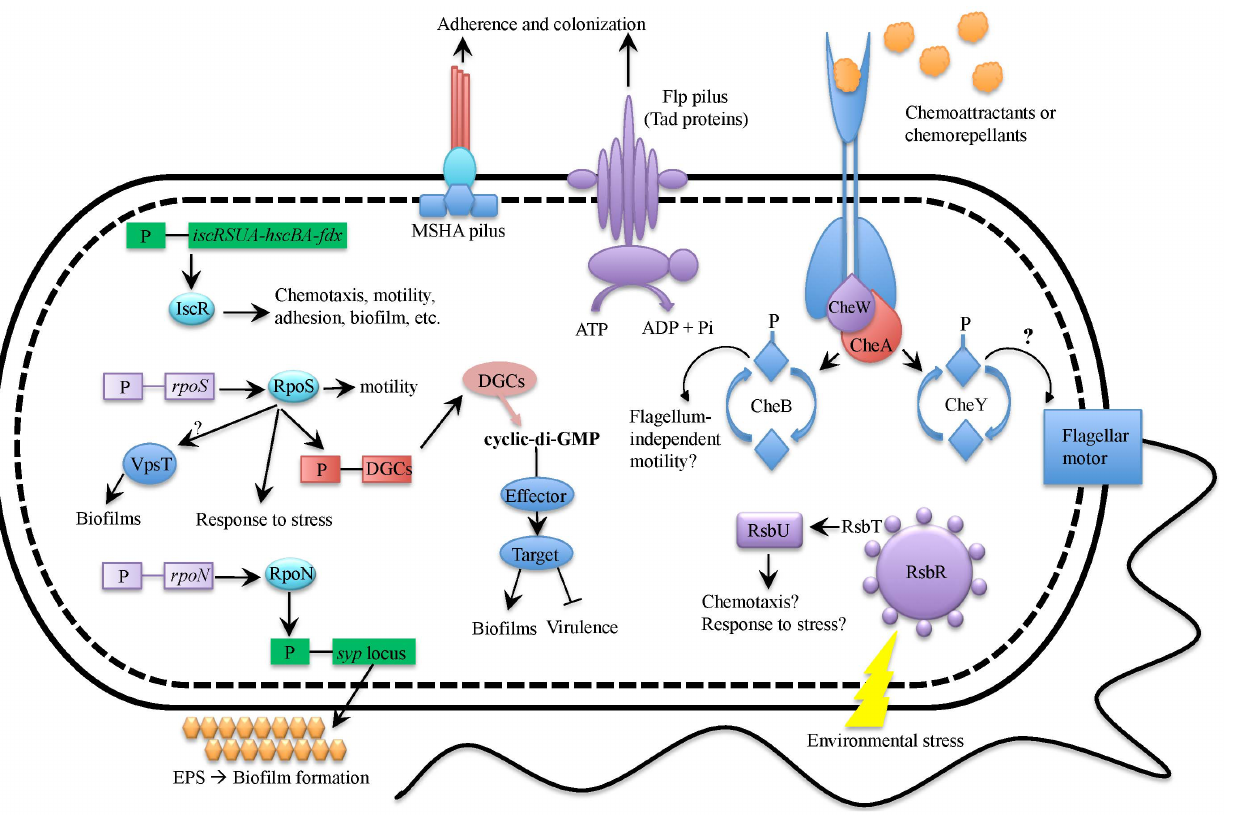
Fig. 7. Diagrammatic summary of genes upregulated in artificial seawater relative to human serum. Depicted in this figure are genes (or sets of genes) upregulated in ASW along with the inferred phenotypic outcomes. The cell expresses several transcription factors involved in stress response, motility, and biofilm formation (RpoS, RpoN and IscR). The cell also expresses genes involved in attachment and biofilm formation including Flp pilus (tad locus), MSHA pilus, and EPS (syp locus). Through the action of diguanylate cyclases (DGCs), the cell has high intracellular concentrations of c-di-GMP which enhances biofilm formation and possibly reduces virulence factor production. In response to chemoattractants and chemorepellents, the cell also engages in chemotactic sensing and signaling which may result in modulation of flagellar rotation and/or flagellum-independent motility. As a result of some unknown environmental cue, the cell also expresses genes involved in the stressosome module (RsbRSTU) which is likely involved in chemotaxis and/or stress response. Note, this diagram is developed based solely on transcriptomic data and further investigation is necessary to establish the proposed model.